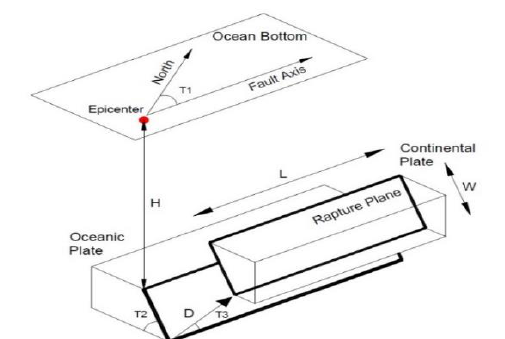
Figure 3. Parameters used for tsunami source modelling including length of rupture (L), width of rupture (W), depth of epicentre from sea floor surface (H), slip (D), dip (T3), strike (T1) and slip/rake (T2) (Heidarzadeh et al., 2007).